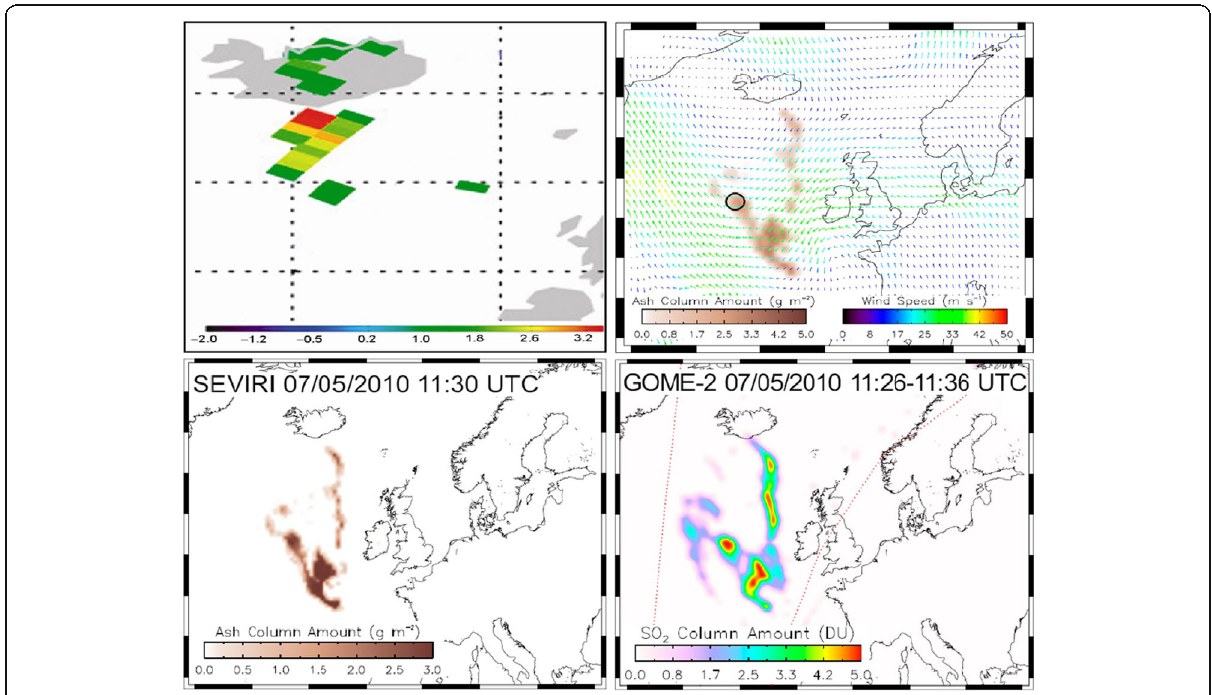
Fig. 10 Related research results (the upper left is the AAI of Eyjafjallajökull volcanic ash cloud on 19 April 2010, the upper right is the 500 hpa data over the North Atlantic on 7 May 2010, the lower left is volcanic ash cloud spatial distribution, and the lower right is the SO2 spatial